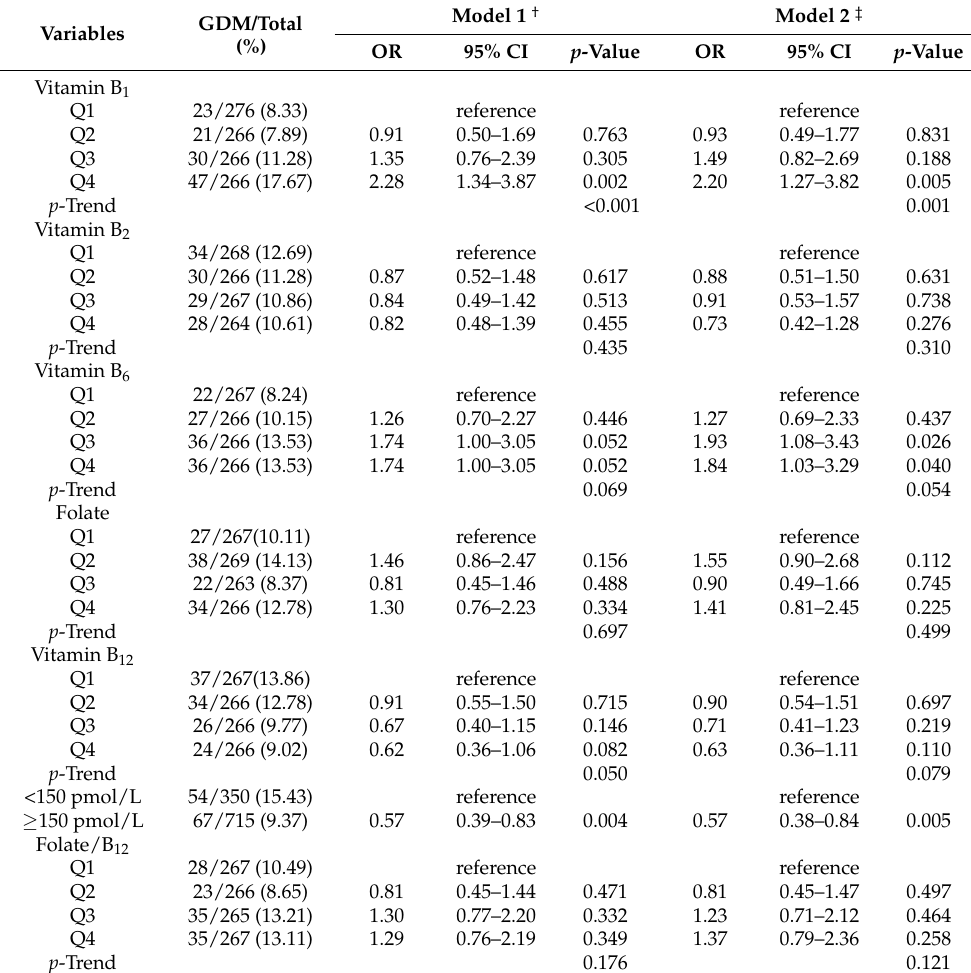
Table 4. Association of maternal serum vitamin B 1 , vitamin B 2 , vitamin B 6 , folate, and vitamin B 12 in early pregnancy with GDM risk (N = 1065).